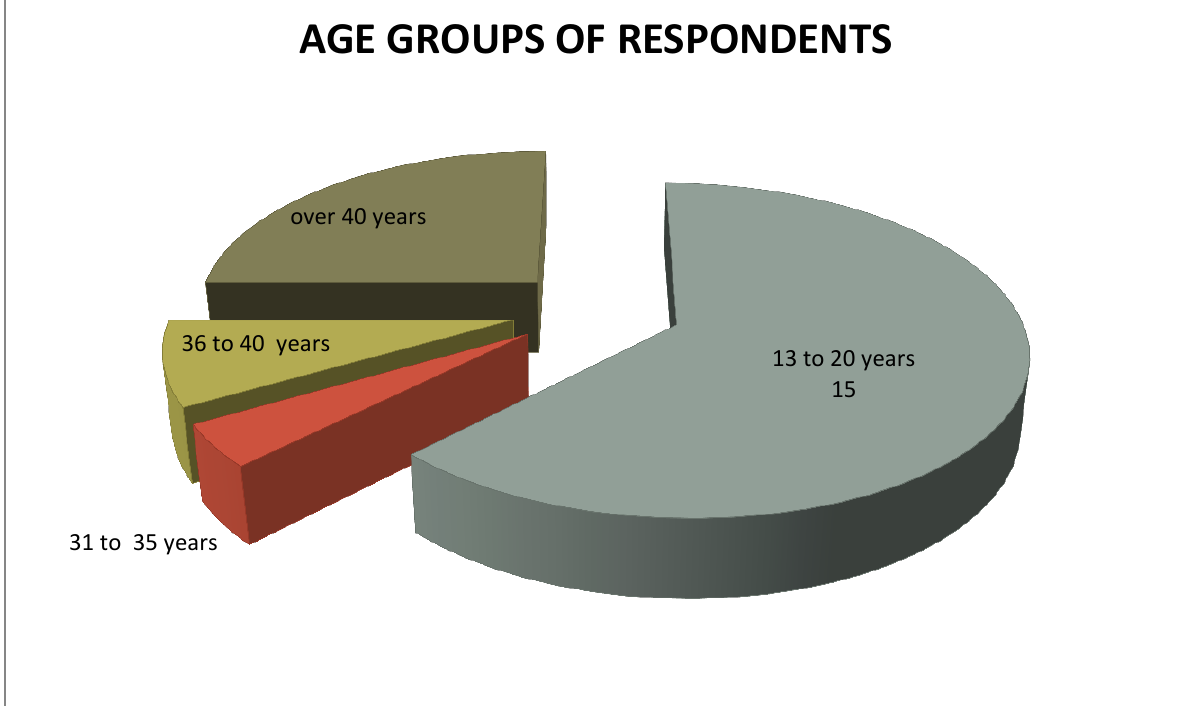
Figure 5.1: The age group of the respondents (Field data,